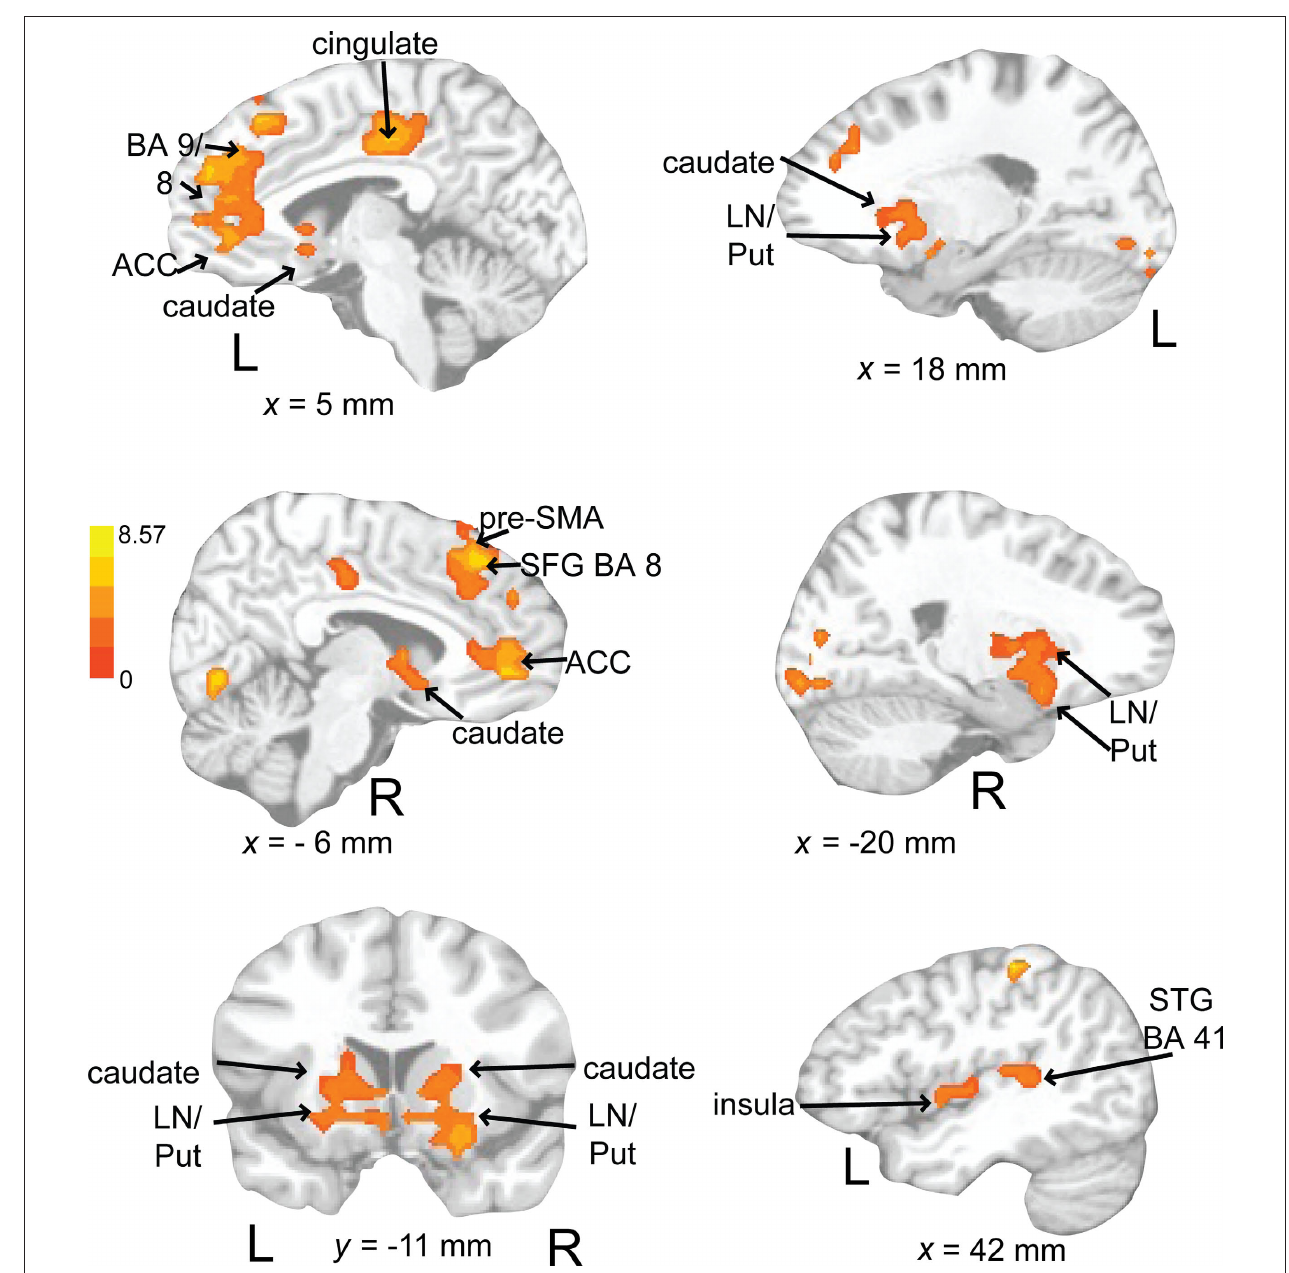
FIguRe 11 | Brain regions where BOLD signal was significantly greater during the auditory rehearse compared to visual rehearse condition ( p < 0.002 corrected). Red to yellow colored voxels represent brain areas where auditory rehearse > visual rehearse . The coronal slice is shown with the